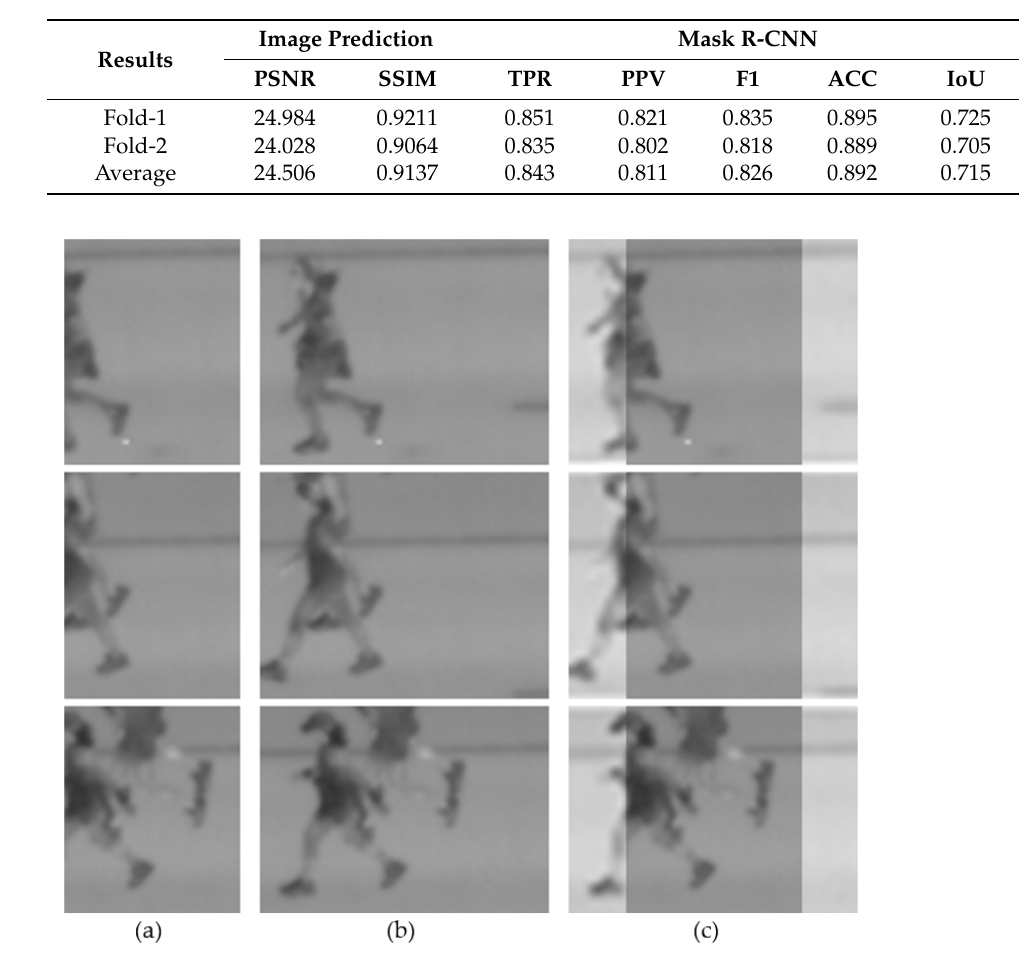
Figure 19. Example images of image prediction from fold-2: ( a ) original images; ( b ) GT images; ( c ) images predicted by the proposed method. Figure 20. Example images of human segmentation from fold-1: ( a ) original images; segmentation results using ( b ) original images and ( c ) GT images; and the images predicted by ( d ) the proposed method.